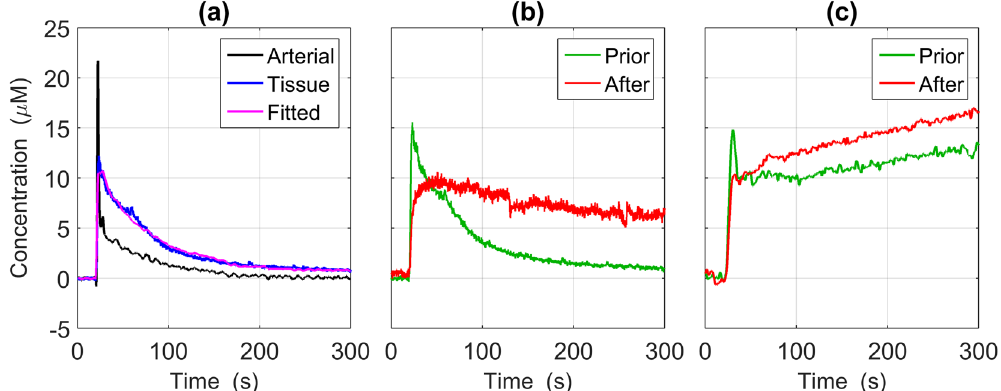
Figure 1. ( a ) Representative tissue ICG (blue) and arterial blood (black) ICG curves from one experiment prior to sonication. The best fit of the kinetic model to the ICG tissue concentration curve is also presented (magenta). Representative tissue concentration curves prior to and after sonication for ICG and IRDye are illustrated in ( b ) and ( c ) respectively. For illustration purposes, all tissue concentration curves were scaled by a factor of 30. The slower clearance of IRDye compared to ICG is due to their different molecular